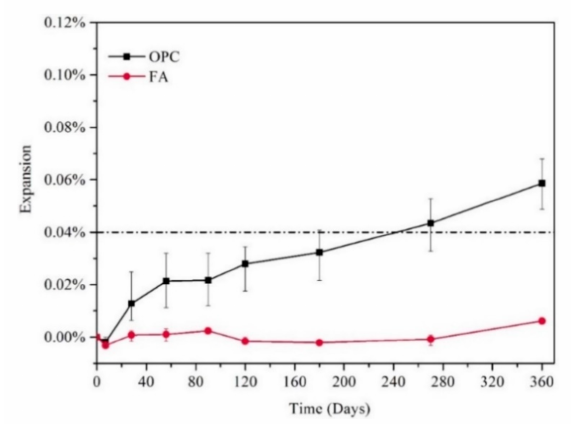
Figure 2. Expansion results of ordinary Portland cement (OPC) and fly ash geopolymer concrete prisms in concrete prism test (CPT).